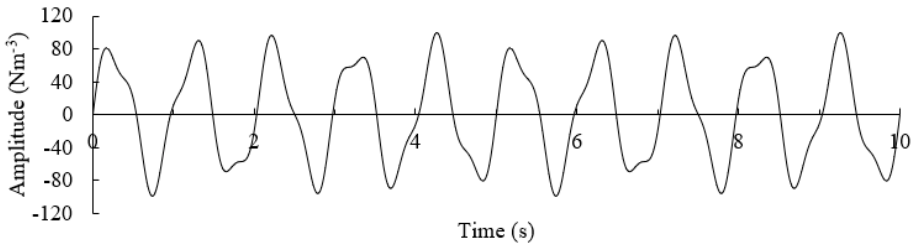
Figure 19. Time history of load.